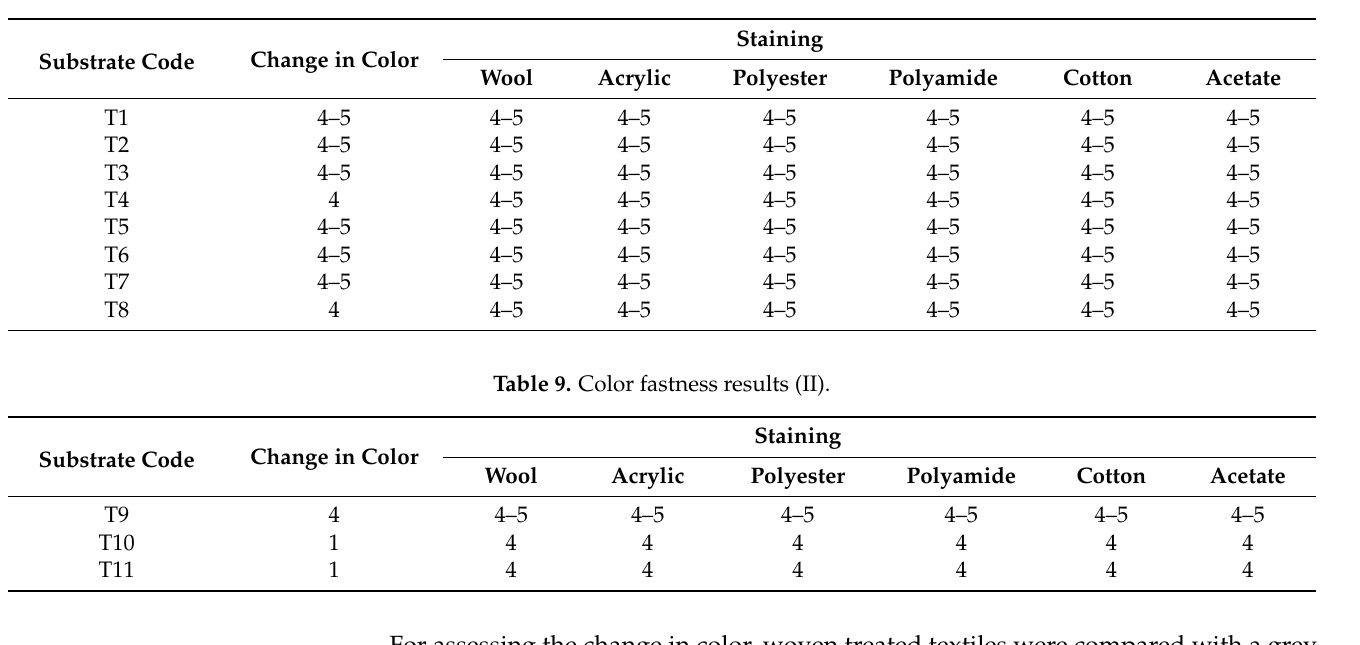
Table 8. Color fastness results (I).